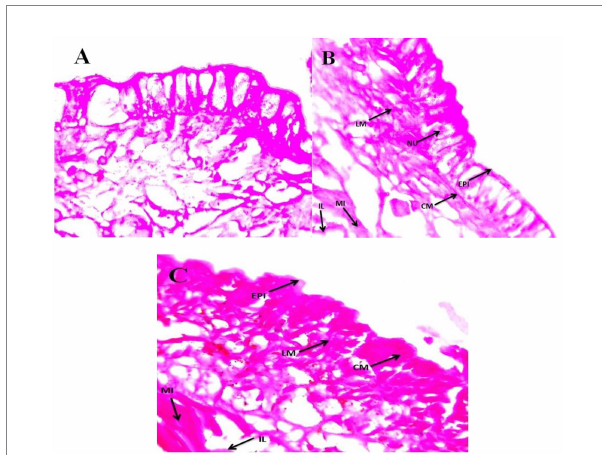
FIGURE 8 Eudrilus eugeniae cross sections magnified at 40× under a light microscope. (A) Control earthworm tissue (no treatment with M. majus ); (B,C) earthworm tissues treated with M. majus . No histopathological changes were observed in the intestinal lumen and intestine of treated earthworms when compared with control earthworms and no fungal conidia were observed in the mid gut cross section. EPI, epidermis; CM, circular muscle; LM, longitudinal muscle; SE, setae; CO, coelom; MI, mitochondrion; IL, intestinal